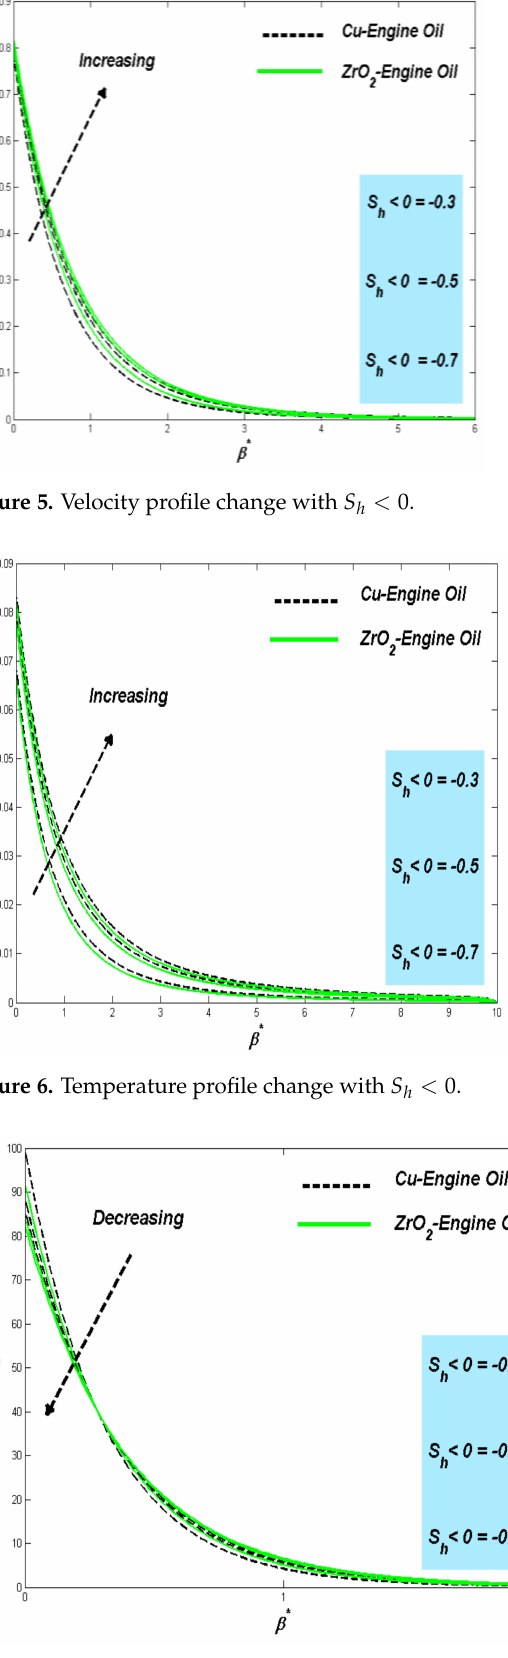
Figure 7. Entropy profile change with S h <